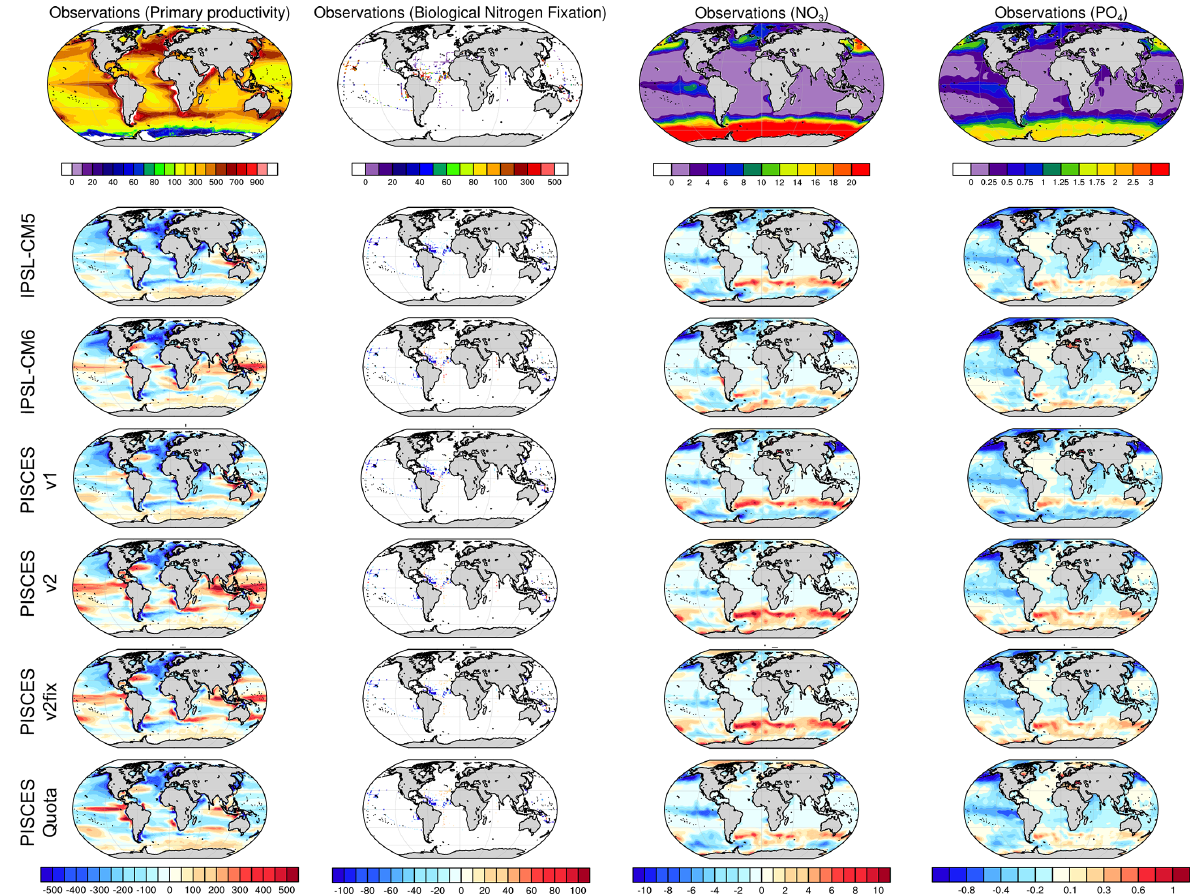
Figure 6. Model–data intercomparison of NPP (mgCm − 2 d − 1 ), N fixation (mmolNm − 2 yr − 1 ), surface NO 3 concentrations (mmolm − 3 ) and surface PO 4 concentrations (mmolm − 3 ). The upper panels show NPP based on remote-sensing observations with the vertically general- ized production model (VGPM) algorithm (Behrenfeld et al., 2005), N fixation from Luo et al. (2014) updated by Landolfi et al. (2018), and NO 3 and PO 4 as provided in the World Ocean Atlas database (Garcia et al., 2013). The other panels show model–data anomalies averaged over the period 1986–2005.